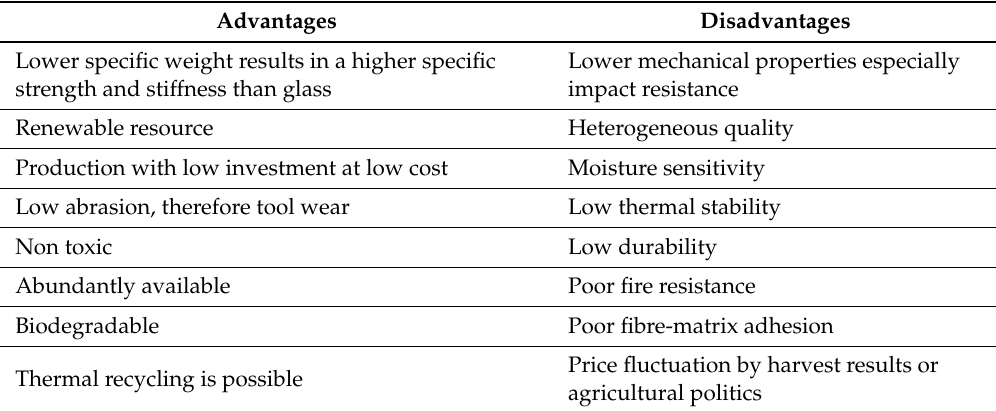
Table 2. Advantages and disadvantages of natural fibres